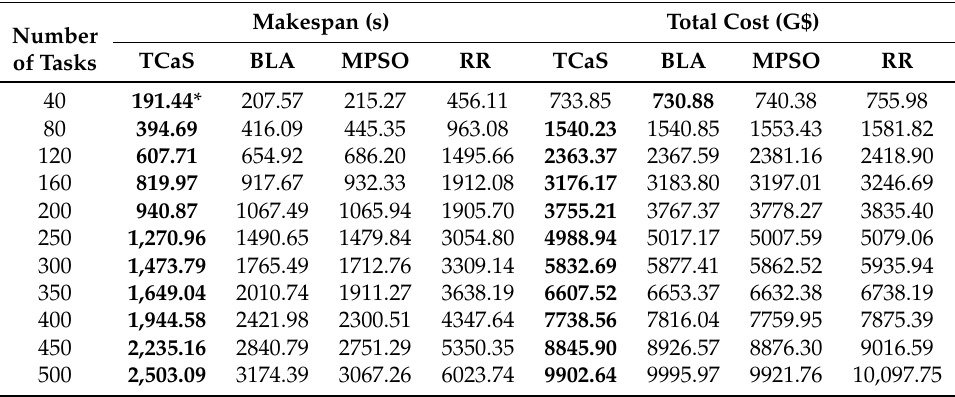
Table 7. Makespan and total cost comparison of the four